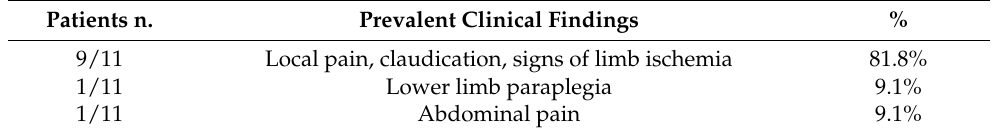
Table 2. Clinical findings of the patients included in the study. Patients n.